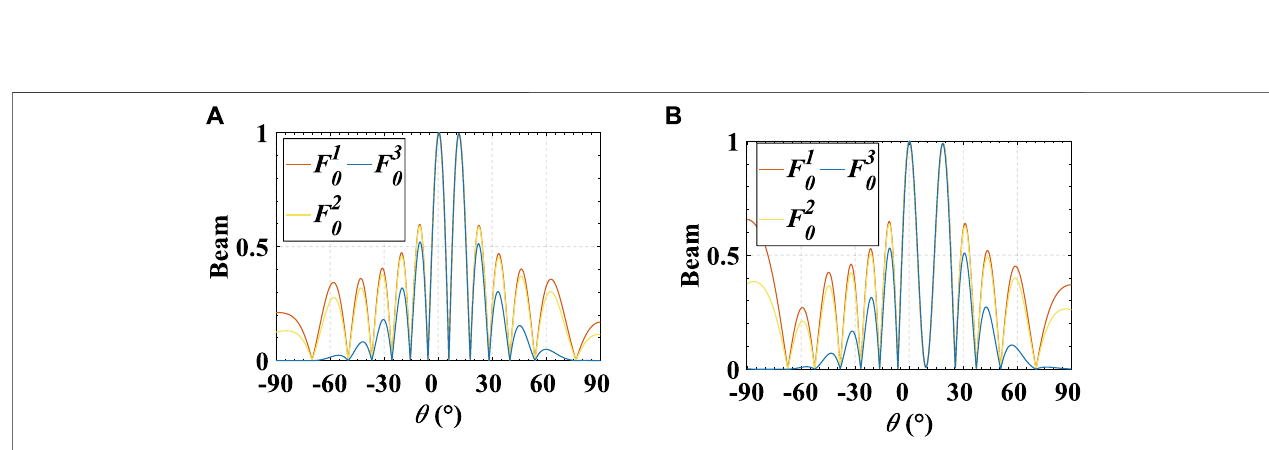
FIGURE 9 | OAM spectrum after beam collimation. (A) OAM spectrum for ( r t , θ t , ϕ t ) (cid:1) ( 1 . 25 m , 0 ° , 0 ° ) ; (B) OAM spectrum for ( r t , θ t , ϕ t ) (cid:1) ( 2 . 5 m , 0 ° , 0 ° ) .